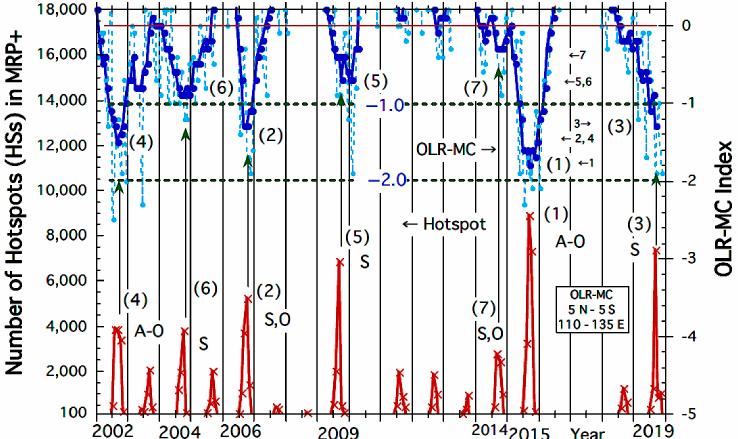
Figure 2. Monthly number of hotspots (HSs) and OLR–MC. (1)–(7) rank the top seven fire years. The fire peak month is shown in abbreviated form A,S and O stand for August, September and October, respectively. A–O means three active fire months from August to October.